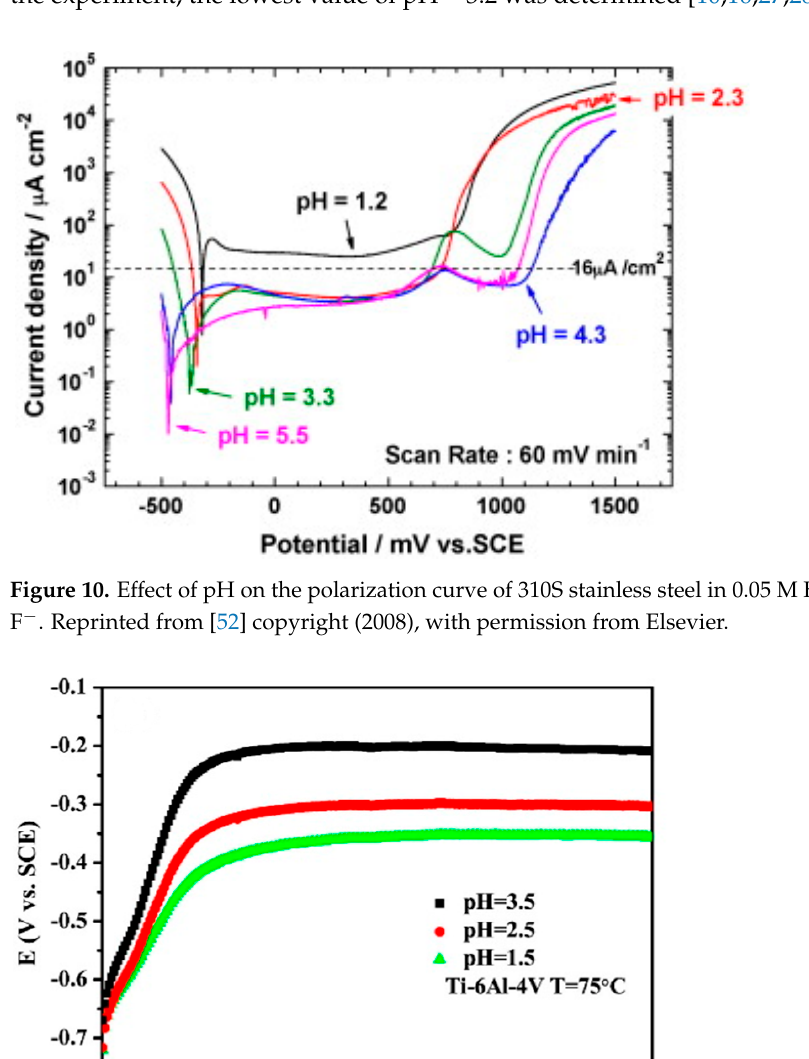
Figure 12. Influence of electrolyte pH (0.05M SO 42 − with 2 ppm HF) on current density of Ti-Al6- V4 and Ta 2 N coating at potentiostatic polarization. Reprinted from [31] copyright (2016), with per- mission from Elsevier. Just as the aggressiveness of the environment affects the corrosion properties, it also affects the contact resistance values, but in an opposite way. ICR increases with rising pH and decreasing temperature (Figure 13). As the passive layer dissolves more slowly in the environment with a higher pH or lower temperature, the passive layer becomes thicker and less conductive [31,52,182]. Figure 13. ( a ) Ta 2 N coated Ti-Al6-V4 alloy before and after PST test in 0.05 M H 2 SO 4 with 2 ppm HF. Reprinted from [31] copyright (2016), with permission from Elsevier. ( b ) Effect of pH and temperature on contact resistance- 310S steel on 0.05 M H 2 SO 4 with 2 ppm HF. Reprinted from [52] copyright (2008), with permission from Elsevier.